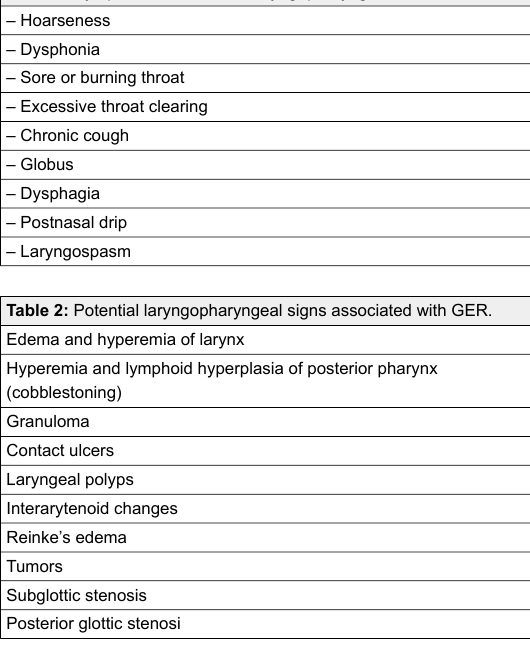
Table 1: Symptoms attributed to laryngopharyngeal reflux.